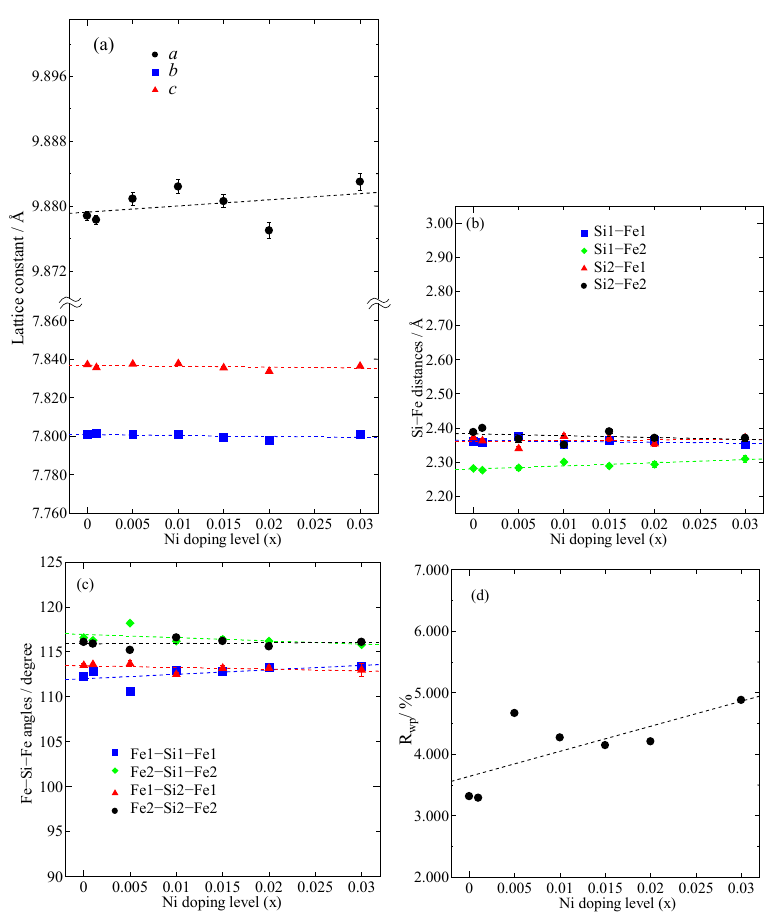
Figure 4. ( a ) Lattice constants a , b , c ; ( b ) interactive atomic distances of Fe-Si, ( c ) interactive atomic angles of Fe-Si-Fe, and ( d ) reliability factor R wp for β -Fe 1 − x Ni x Si 2 (0 ≤ x ≤ 0.03) at room temperature.